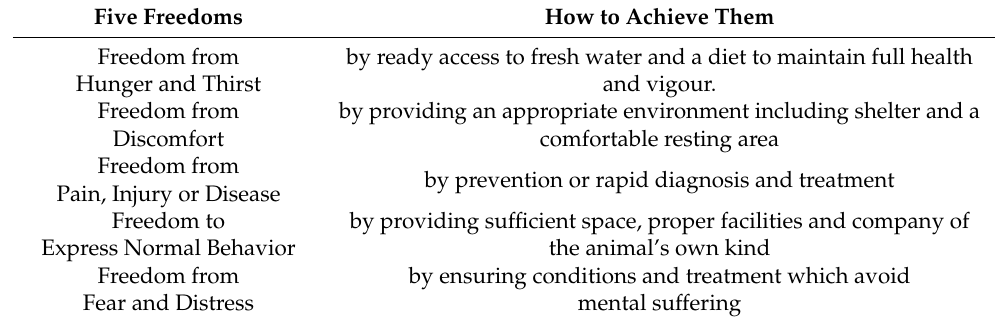
Table 1. Brambell’s Five Freedoms